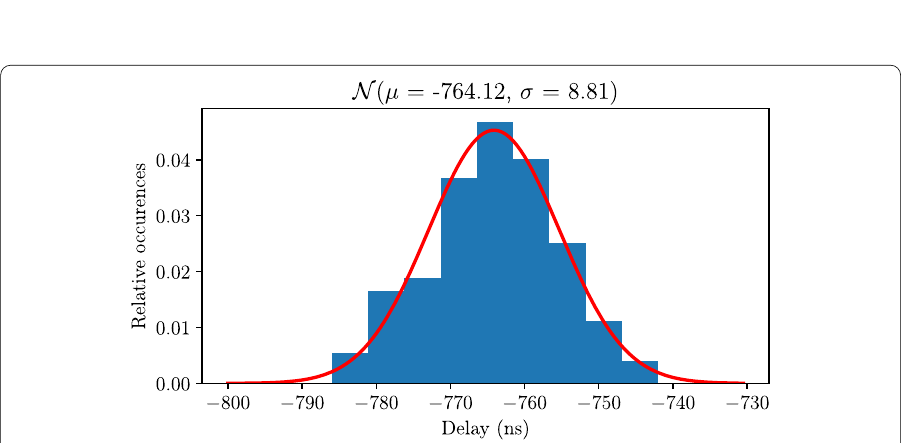
Fig. 2 Histogram of measured offset and its Gaussian fit for 5000 packet